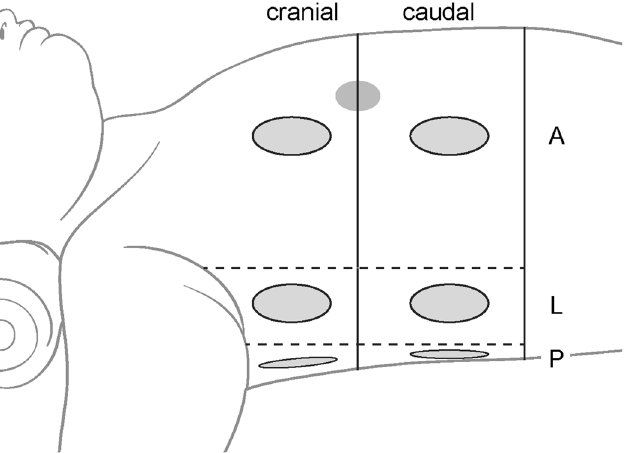
Figure 1. Segmentation of lung ultrasonography. The black axial line divides the thorax into the cranial and caudal regions based on the nipple. The vertical line divides the lung into A: anterior, L: lateral, P: posterior based on the parasternal, anterior, and posterior axillary